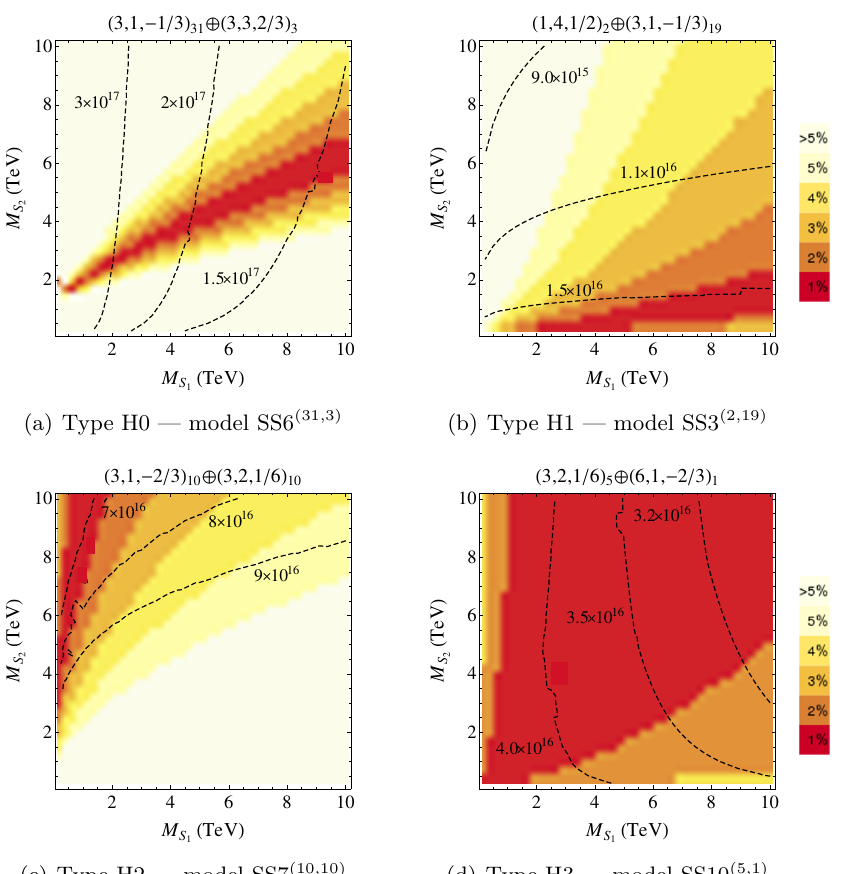
Figure 1 . Examples of various types of the BSM spectra observed in the unification models. Shown is distribution of the mismatch parameter (cid:15) SSJ ( N S ,N S ) scenarios listed in table 5. PGU region ( (cid:15) 1 2 of yellow illustrate departure from the precise unification condition as quantified by the increasing values of (cid:15) . Dashed black contours indicate the unification scale (in GeV GUT